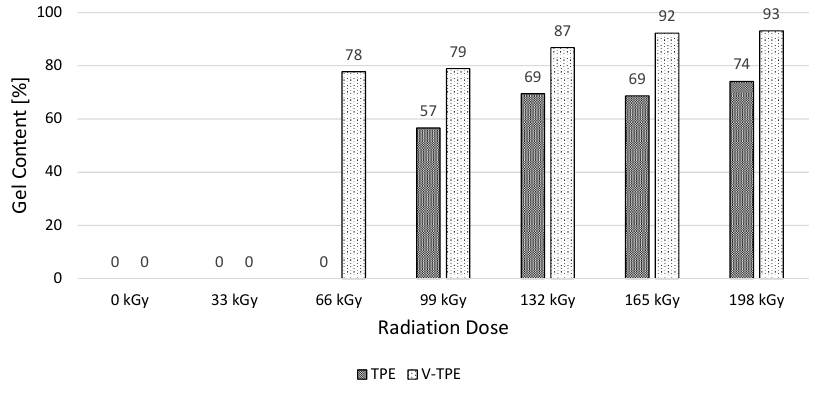
Figure 4. Gel content of irradiated TPE and V-TPE.